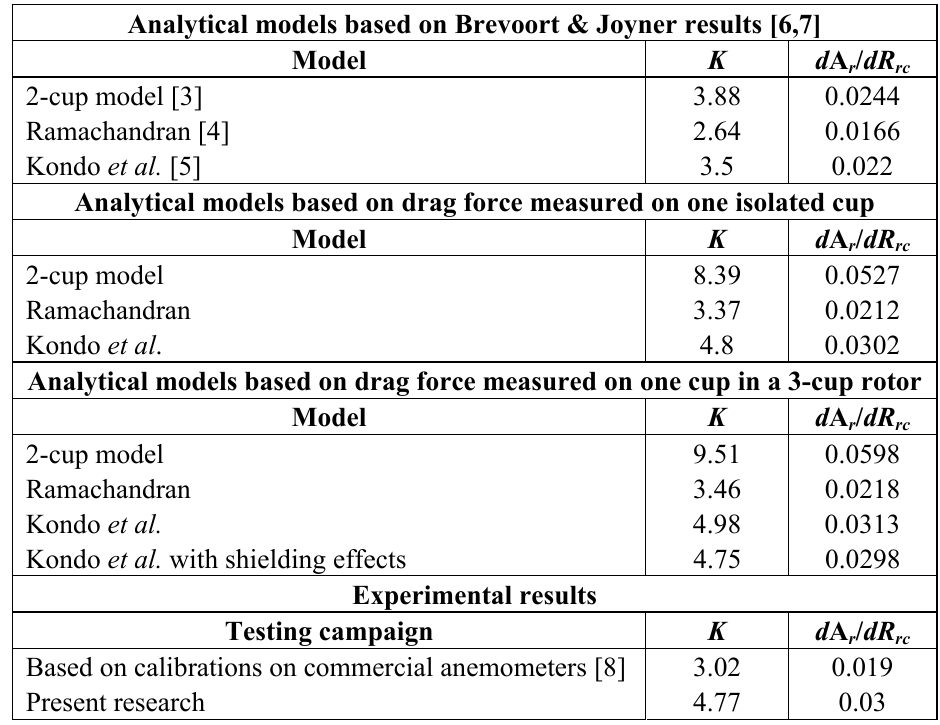
calibration constant as a function of Table 5. Anemometer factor, K , and slope of the A r / dR , calculated with the different methods explained in the text. the rotation radius, d A r rc The experimentally measured results are also included in the table.